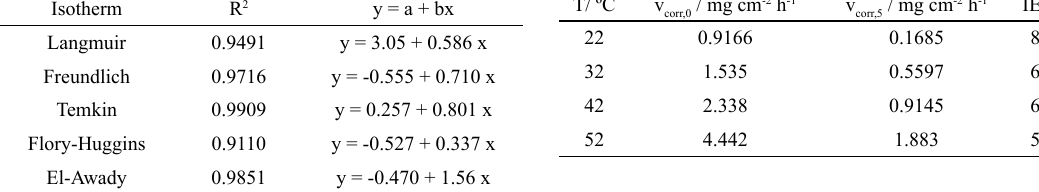
Table 3. Temperature effect on the corrosion rate and on the inhibition efficiency of AEAW on the stainless steel surface in H